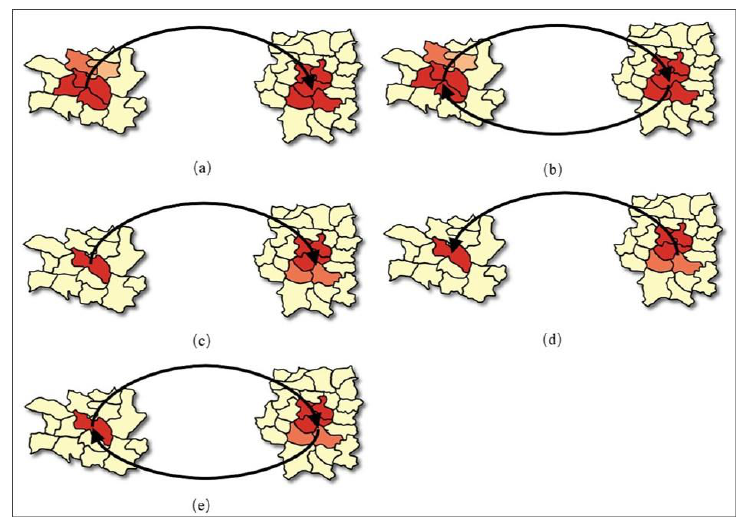
Figure 8. Basic categories of RG-Flow-Pattern based on geo-information Tupu. ( a ) Many-to-many regions and single direction RG-Flow-Pattern; ( b ) many-to-many region and double direction RG-Flow-Pattern; ( c ) one-to-many single direction RG-Flow-Pattern; ( d ) many-to-one single direction RG-Flow-Pattern; and ( e ) one and many double direction RG-Flow-Pattern.